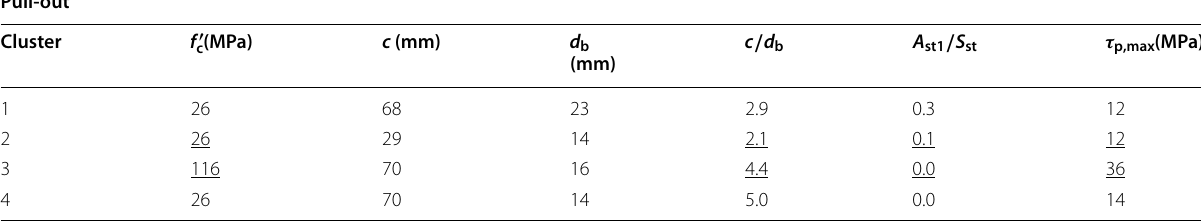
Table 4 Feature values of each cluster (pull‑out data set).